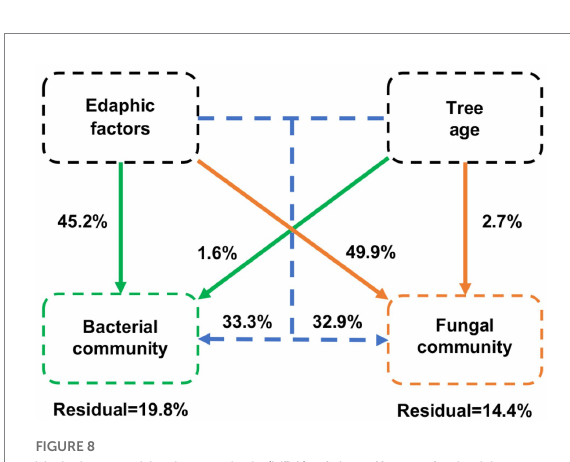
FIGURE 8 Variation partitioning analysis (VPA) of the effects of edaphic factors and age of blueberry plantings on bacterial and fungal communities. Edaphic factors include pH; SOM, soil organic matter; TC, total carbon content; TN, total nitrogen content; TP, total phosphorus content; TK, total potassium content; NH 4+ -N, nitrate nitrogen; NO 3 − -N, ammonium nitrogen; AP, available P content; and AK, available K